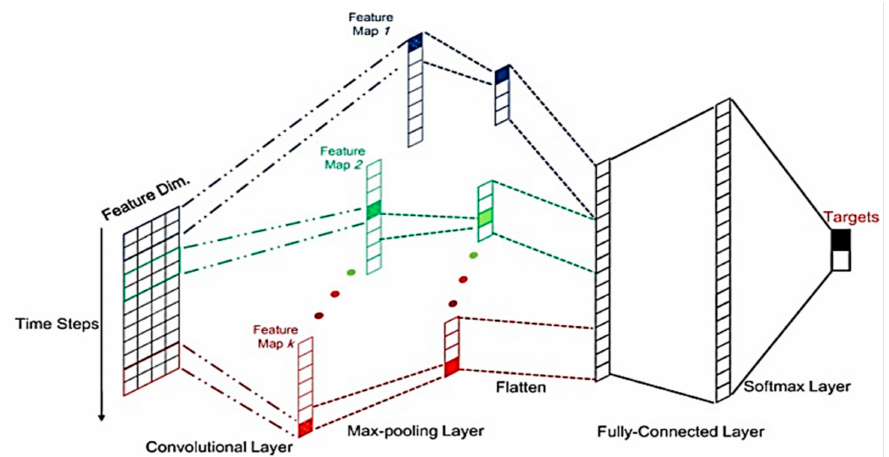
Figure 5. The three main layers of a CNN with the softmax layer. Copyright © 2021 Elsevier